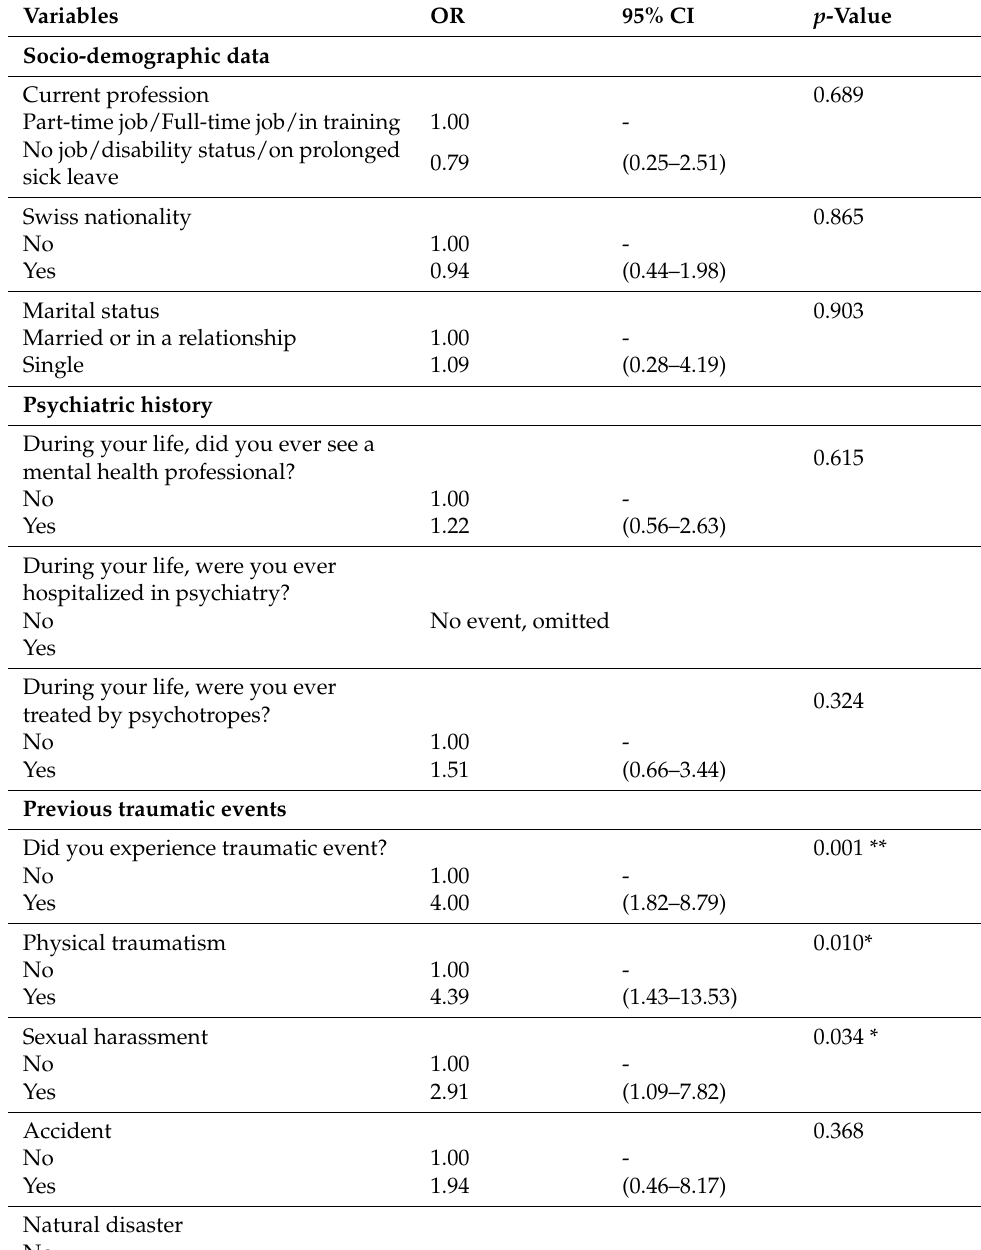
Table 6. Variables associated with traumatic childbirth according to the DSM-5 criteria (measures of associations, univariate